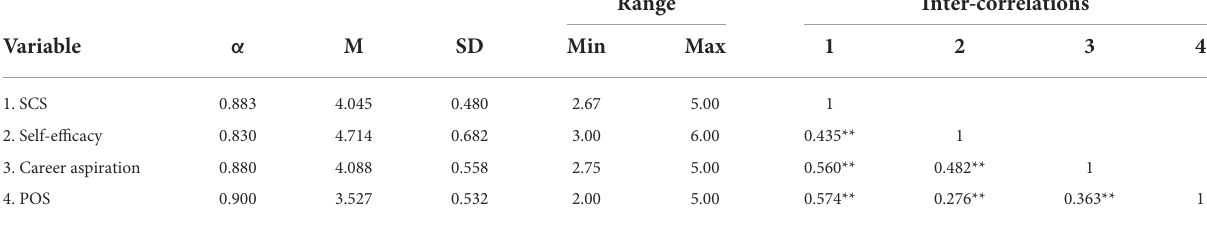
Range Inter-correlations